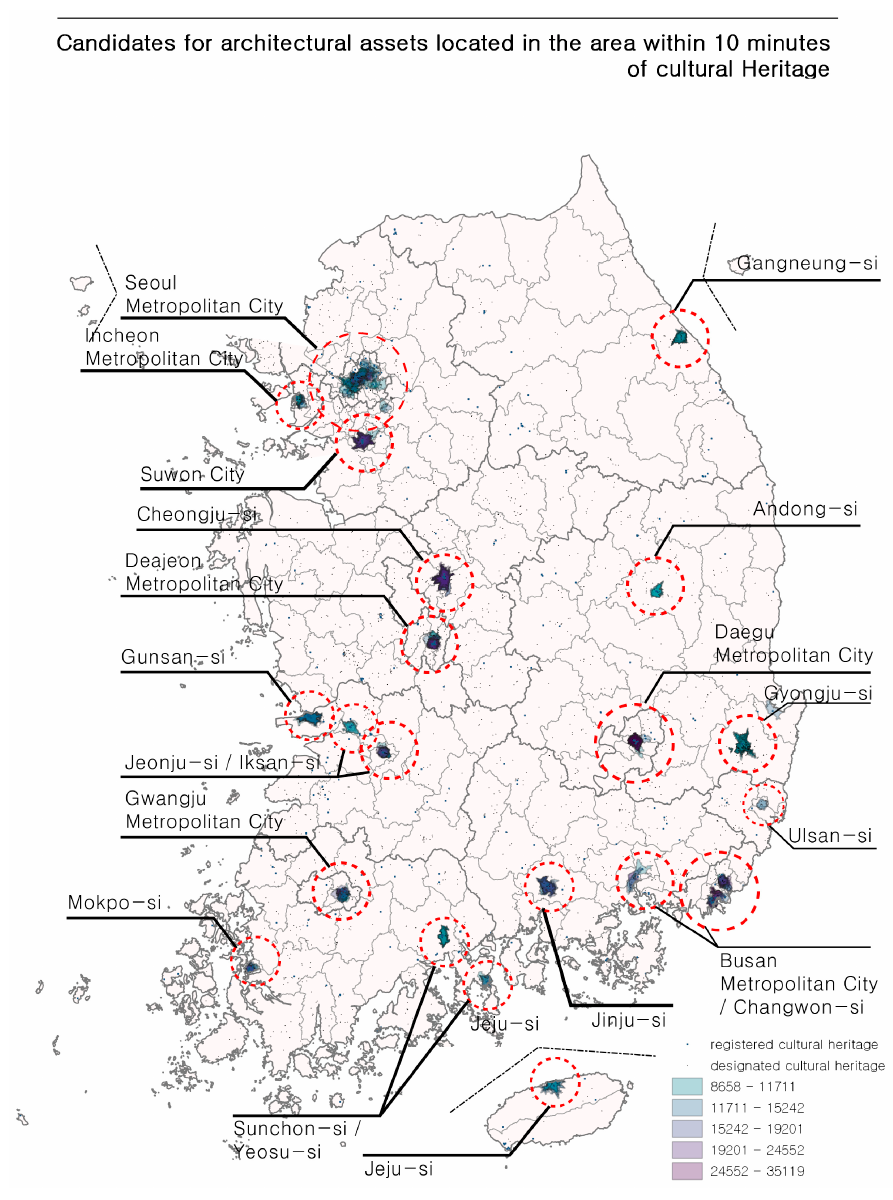
Figure 6. Top areas of candidate areas for AAVE zones.